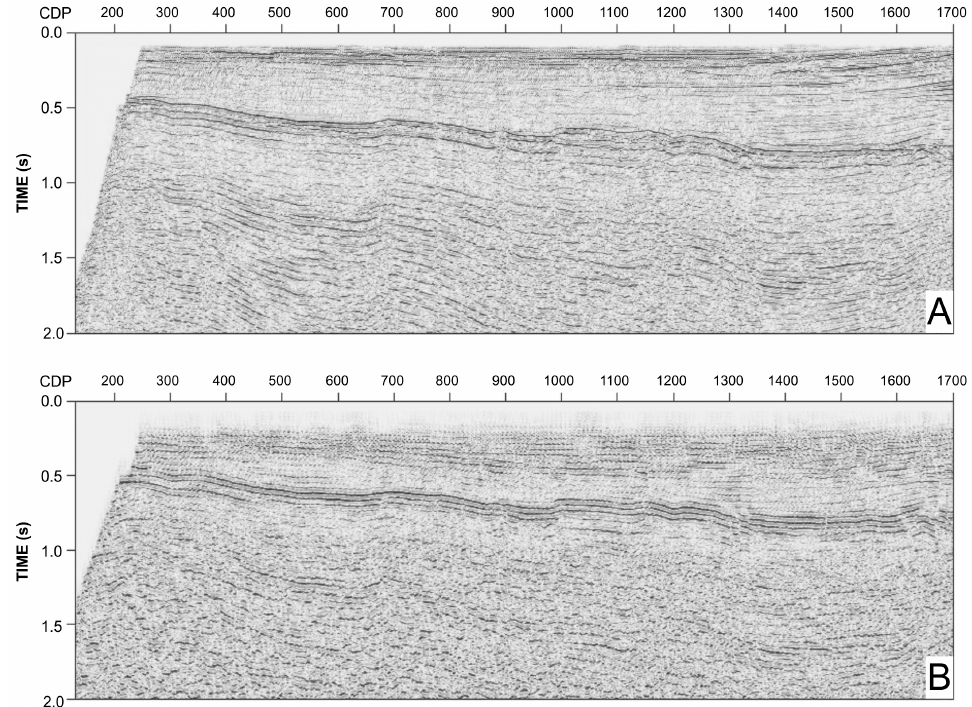
Figure 2. Stack section without (panel ( A )) and with (panel ( B )) the application of WED.